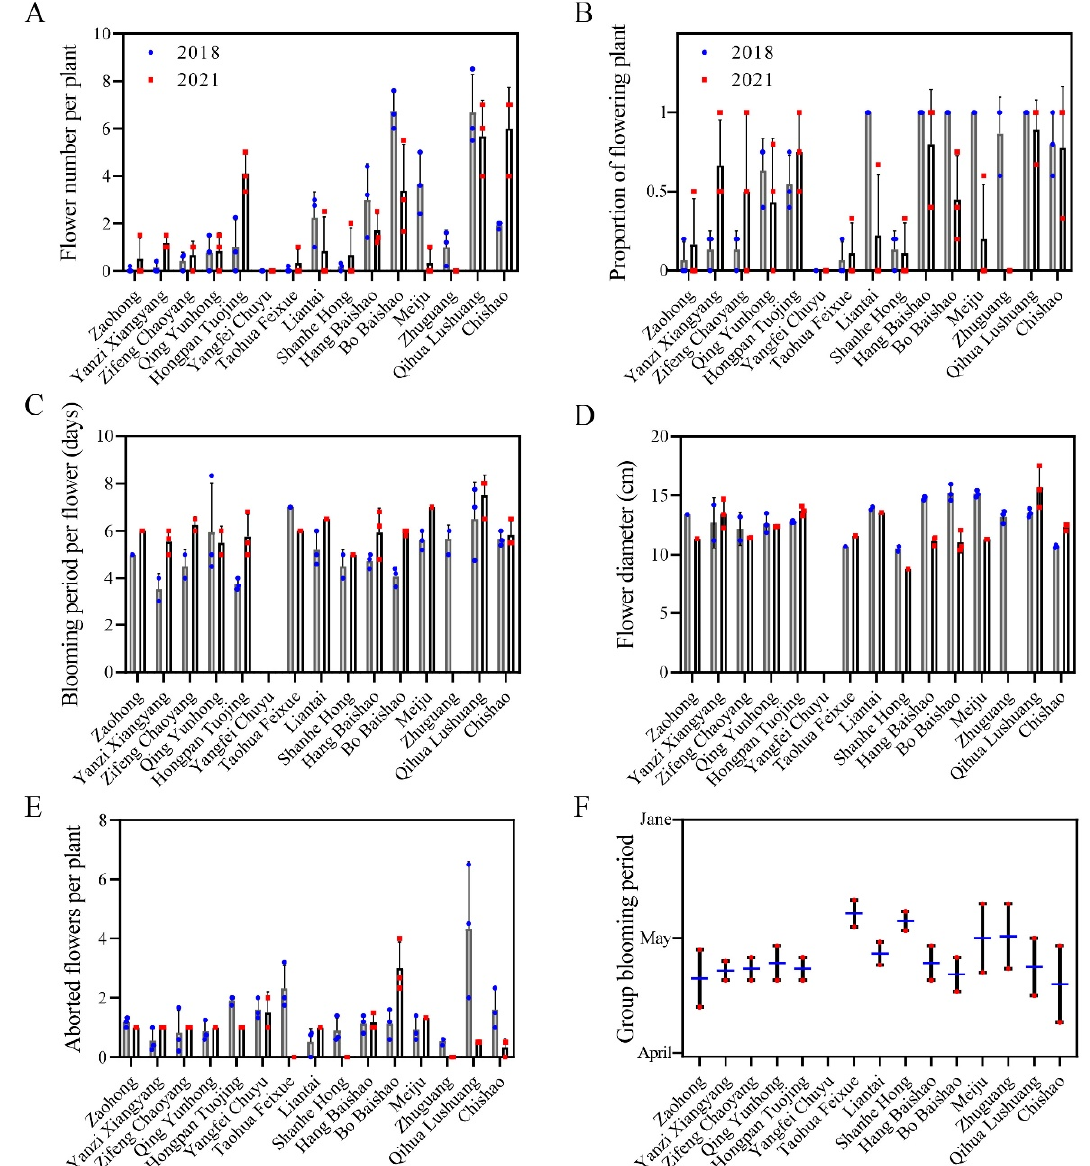
Figure 3. Observations and changes of ornamental features-related indices of the fifteen peony cultivars. ( A ) Flower number per plant; ( B ) Proportion of flowering plant; ( C ) Blooming period per flower; ( D ) Flower diameter; ( E ) Aborted flowers per plant; ( F ) Group blooming period. Values represent the means ± standard deviation of three replicates.